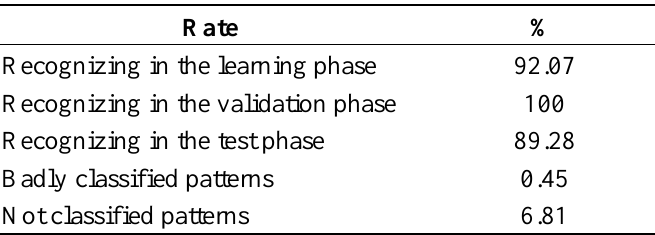
Table 6. Results of the ANN